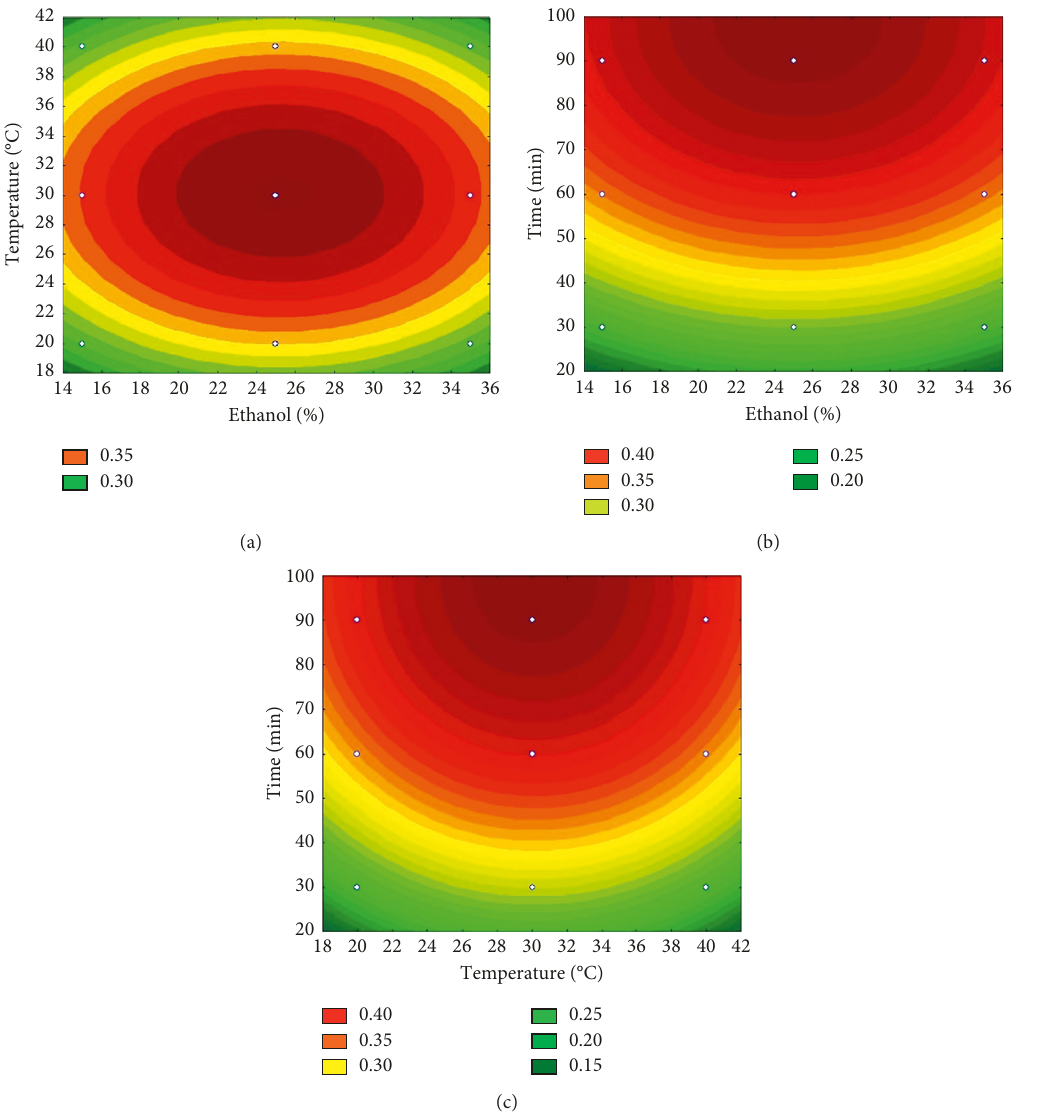
1 ) of permeabilized cells from mL · −